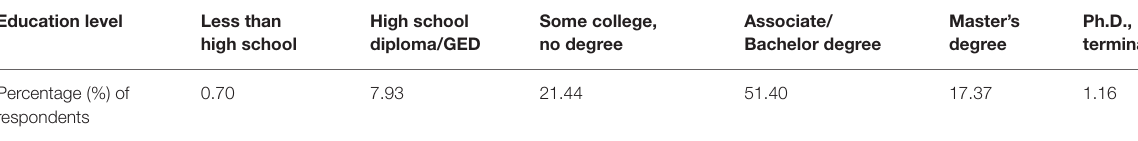
TABLE 1 | Responses to the question “Please indicate the highest level of education that you have completed.” Education level